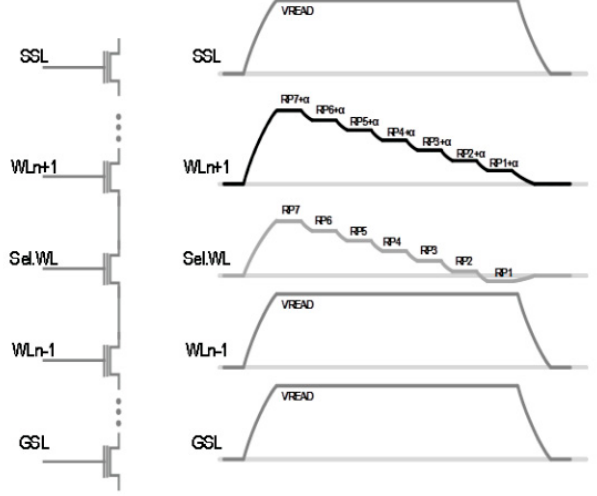
Figure 6. Couple-capacitance-minimizing technique. Reprinted/adapted with permission from Ref. [50], 2019, IEEE.